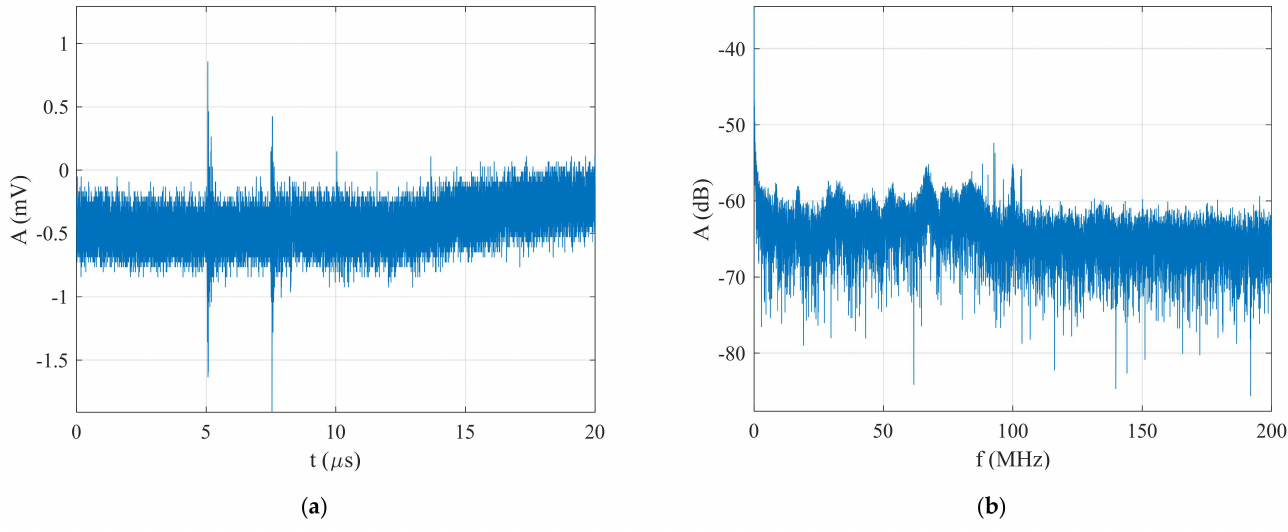
Figure 11. The generated BPSK signal in the form of Barker Code 11 at an SNR = − 24 dB : ( a ) time domain, and ( b )